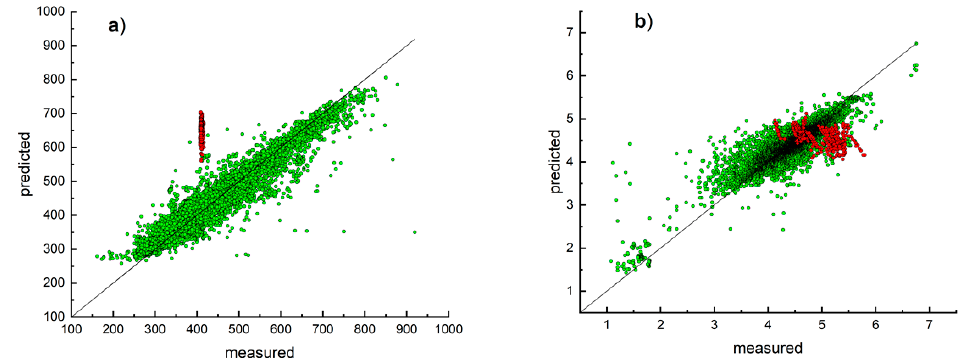
Figure 3. Distribution of the experimental and predicted values of the position of the absorption band ( a ) and values of the extinction coefficient ( b ) using models based on the JOUNG set. The green and red colors correspond to the training set data and test set data of 335 compounds, respectively.